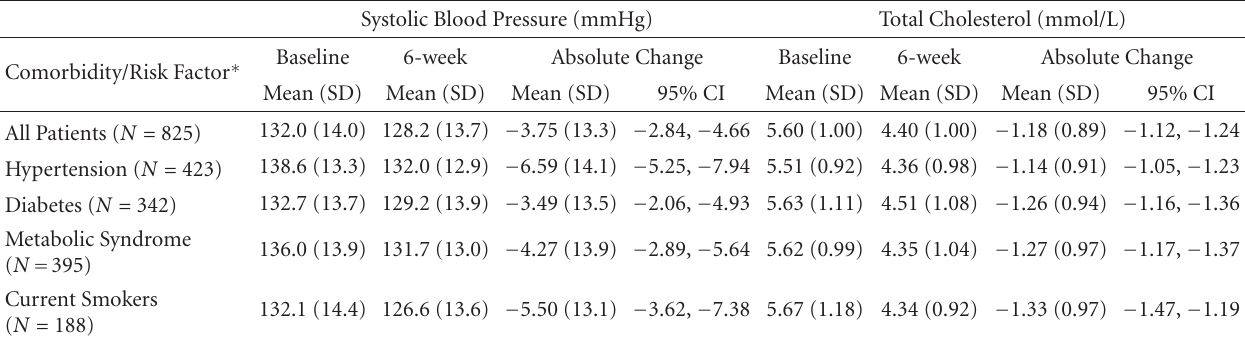
Table 1: Modifiable SCORE risk factors at baseline and final (6-week)